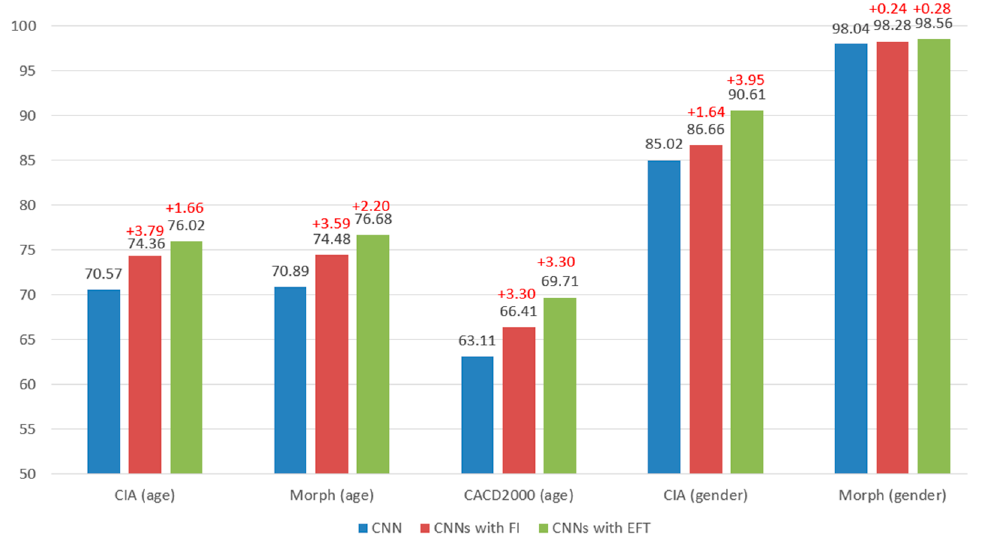
Figure 10. Accuracy in different CNNs on the three databases.